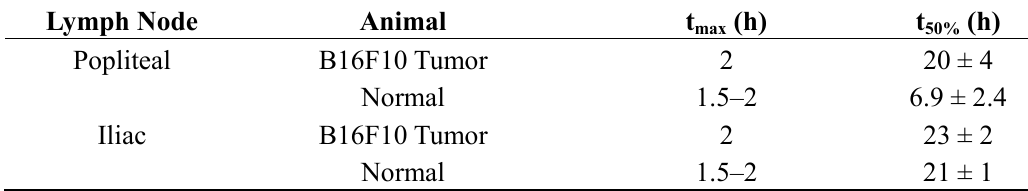
Table 6. t , t , and AUCs for the popliteal and iliac nodes after s.c. administration of max 50% 74 kDa HA- IR820 conjugate into the footpad of normal and B16F10 tumor bearing